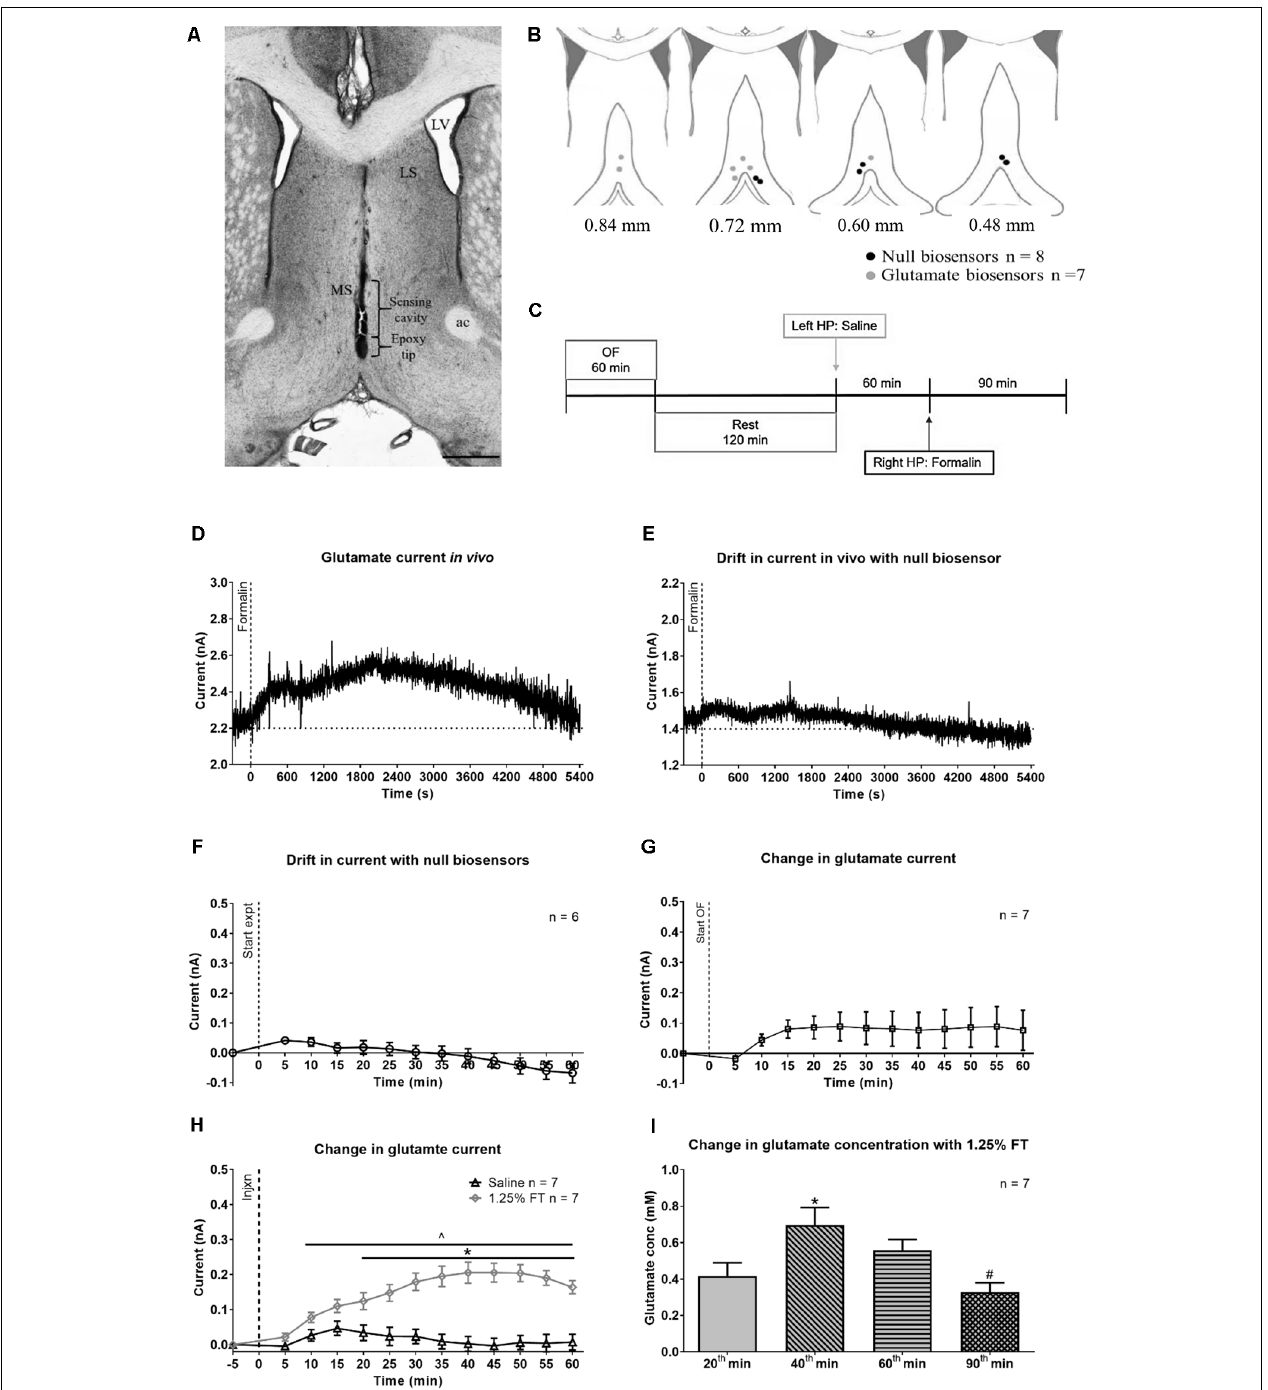
FIGURE 6 | Change in glutamate current and concentration with hind paw (HP) injection of saline or 1.25% formalin. (A) Digital representative image of the track made by the biosensor in the midline MS. The deepest point of the track corresponds to the epoxy tip of the biosensor, which protects the sensing cavity of the biosensor during insertion through the implanted guide cannula. The sensing cavity is 1.0 mm long and is right above the epoxy tip. The scale bar on the image represents 1.0 mm. (B) Diagrammatic representation of the biosensor recording sites in the MS. The position of the epoxy tip of the null biosensor (black circles) and glutamate biosensors (gray circles) are shown. The diagram is adapted from Paxinos and Watson (2014). (C) Experimental timeline illustrating the recording of amperometric current in open field (OF) for 60 min followed by a 2 h rest in the home cage. The animal was sequentially injected with saline and 1.25% formalin into the left and the right hind paw (HP), respectively. The two hind paw injections were spaced 60 min apart. (D) Hind paw injection of 1.25% formalin (‘Formalin’ on the